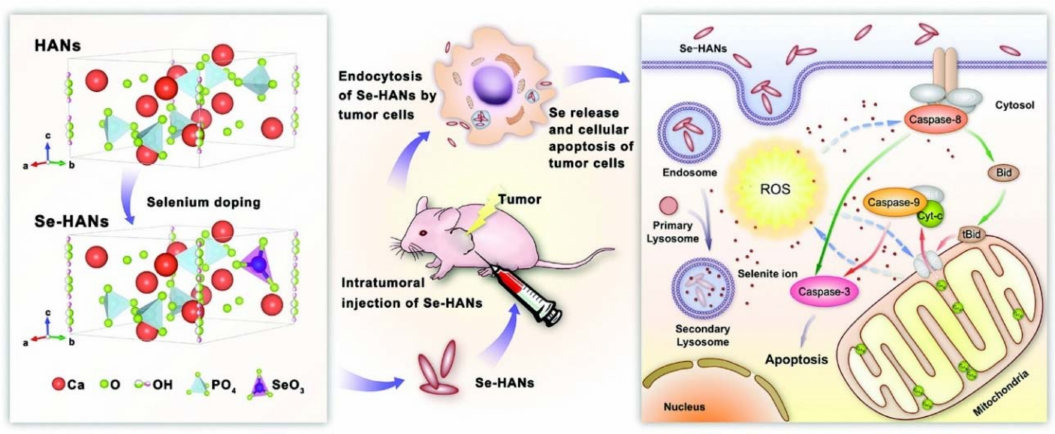
Figure 7. Preparation and working principle of antitumor nanoparticles. Se-HANs were fabricated using selenite to replace phosphate of HANs. Intratumoral injection of Se-HANs was performed on the xenograft osteosarcoma model. Se-HANs were internalized into tumor cells by nonspecific endocytosis and rapidly degraded in the acidic lysosome to release selenium. Cell apoptosis was activated by a primary, selenium-induced, caspase-dependent apoptosis pathway synergistically orchestrated with the ROS generation. Reprinted from [37] with permission. Copyright (2016) American Chemical